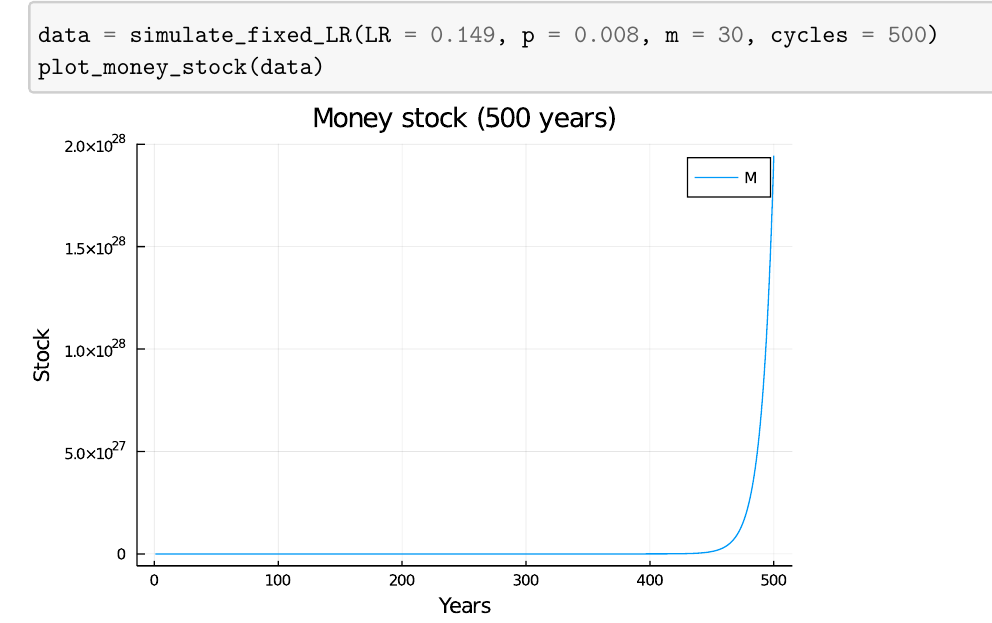
Figure 17. Money stock (LR = 14.9%, p = 0.8%, m = 30 years).